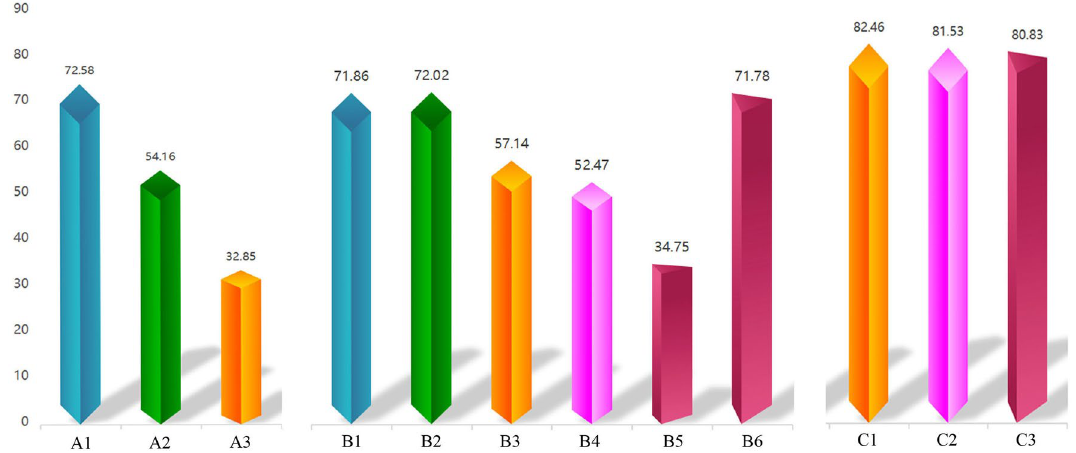
Figure 5. RFA fraction of each Subgroups. Subgroups name of A1–C3 refer to Table 3.